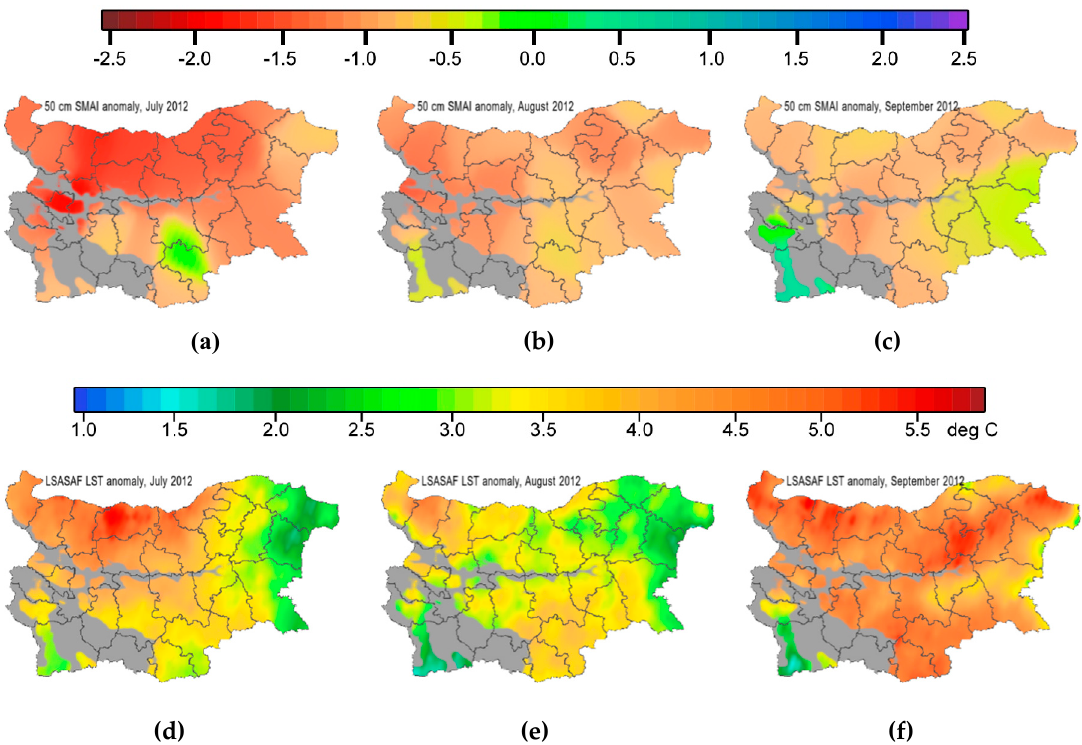
Figure 7. Monthly mean anomalies distribution over Bulgaria, 2012 of SMAI (50 cm soil layer) for ( a ) July, ( b ) August, and ( c ) September, and of LSASAF LST 0900 UTC for ( d ) July, ( e ) August, and ( f ) September. Anomalies are calculated for the 2007–2018 period.